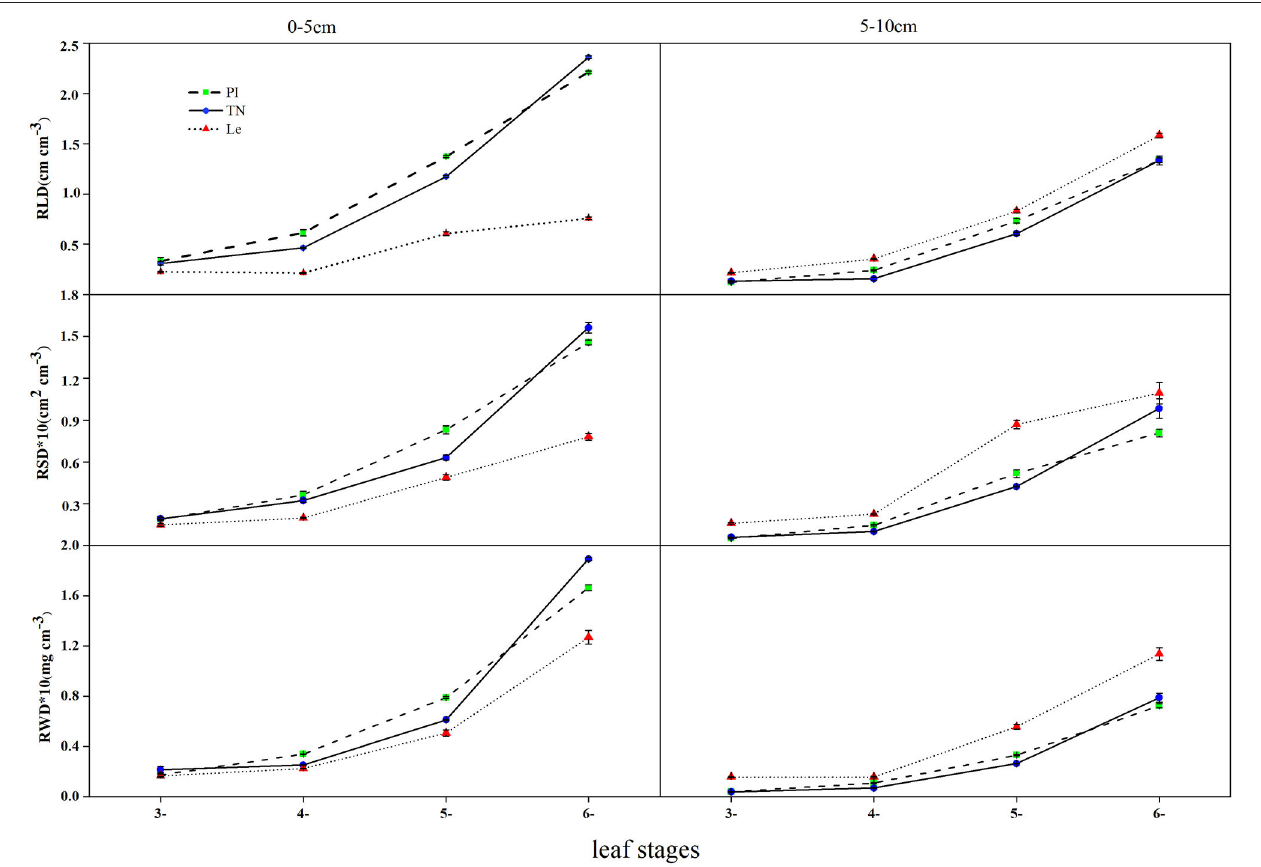
FIGURE 1 | Root length density, root surface area density, and root dry weight density in the 0–5 and 5–10cm soil layers at the 3–6 leaf stage. PI, allelopathic rice PI312777; TN, allelopathic rice Taichung Native1, and Le, non-allelopathic rice Lemont. Error bars indicate standard